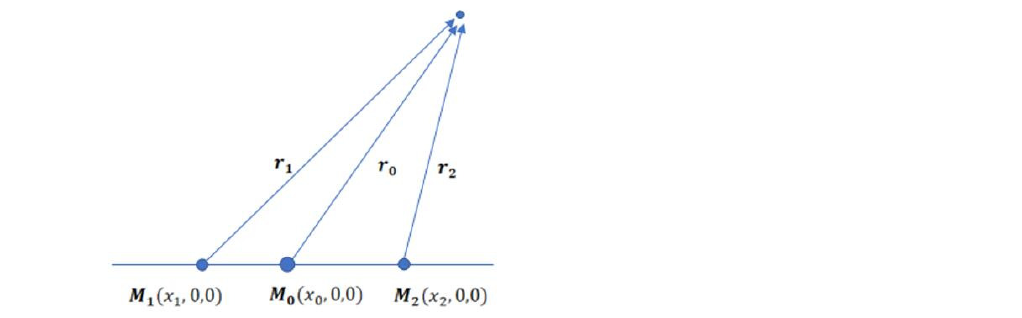
Figure 2. The equivalent schematic diagram of equivalence between two magnetic dipoles and a single magnetic